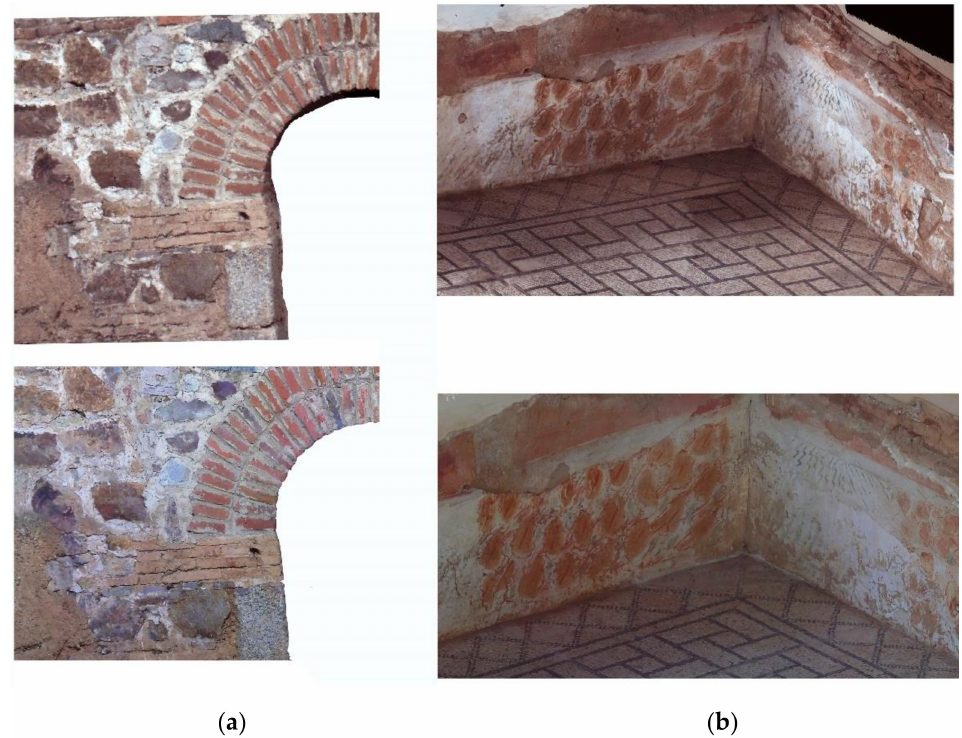
Figure 11. Detail of the point clouds of work zones 2 ( a ) and 3 ( b ) obtained with both systems. The two images in the upper part belong to those obtained with the proposed system and those obtained with the Focus3D X 330 are shown in the lower